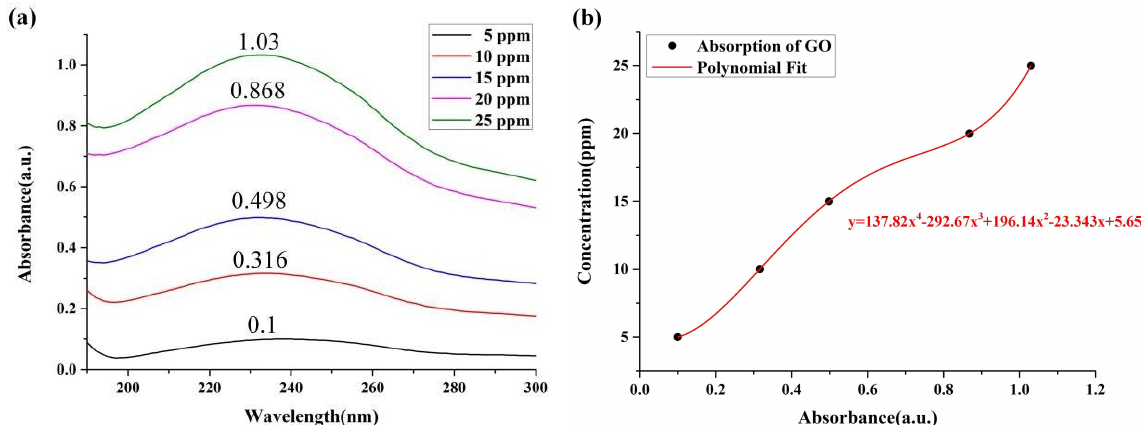
Figure 10: Different concentrations of GO (a) UV-Vis; (b) Eq. (1)